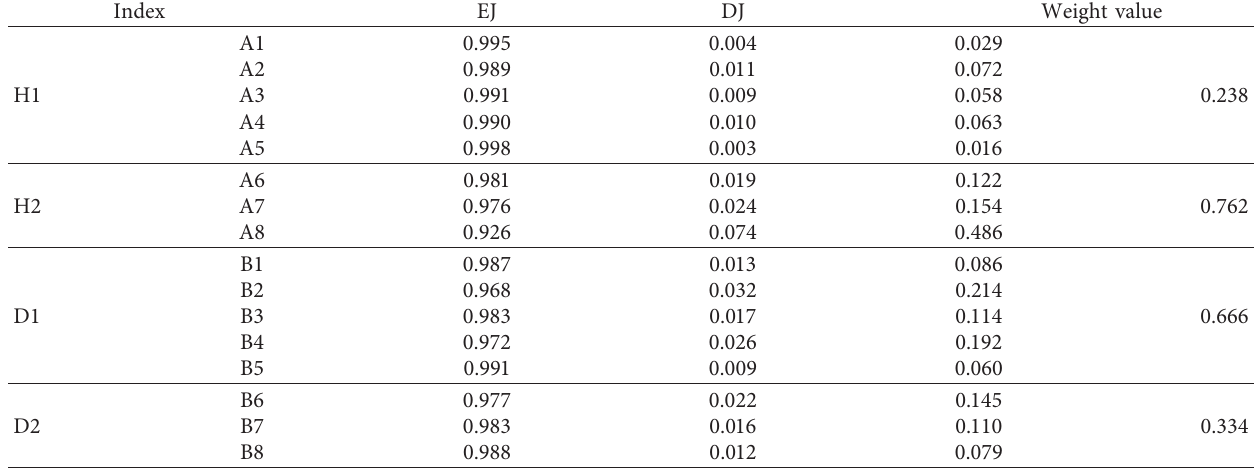
Table 2: The entropy weight of